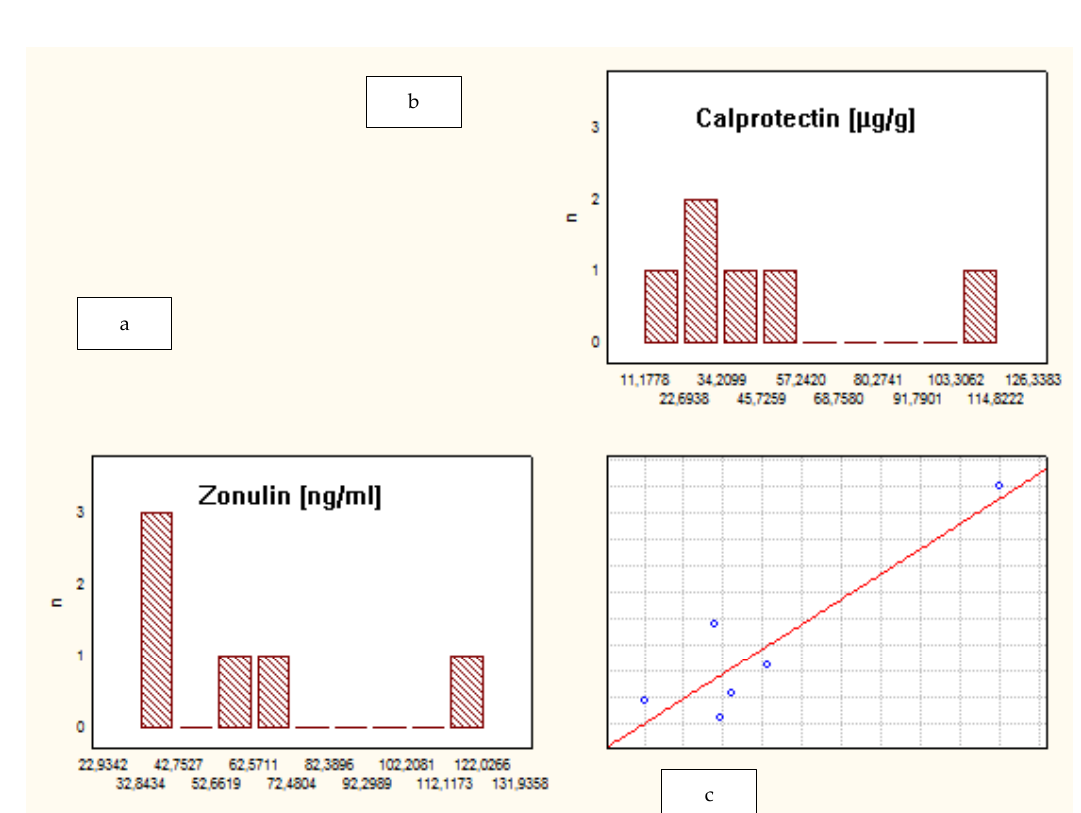
Figure 4. Correlation between fecal zonulin and calprotectin levels in the control group. ( a ) Levels of fecal zonulin in the control group; ( b ) levels of fecal calprotectin in the control group; ( c ) the correlation between levels of fecal zonulin and calprotectin in the control group.